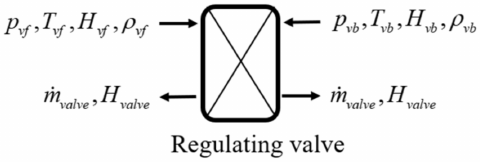
Figure 6. Interface parameters of regulating valve model.